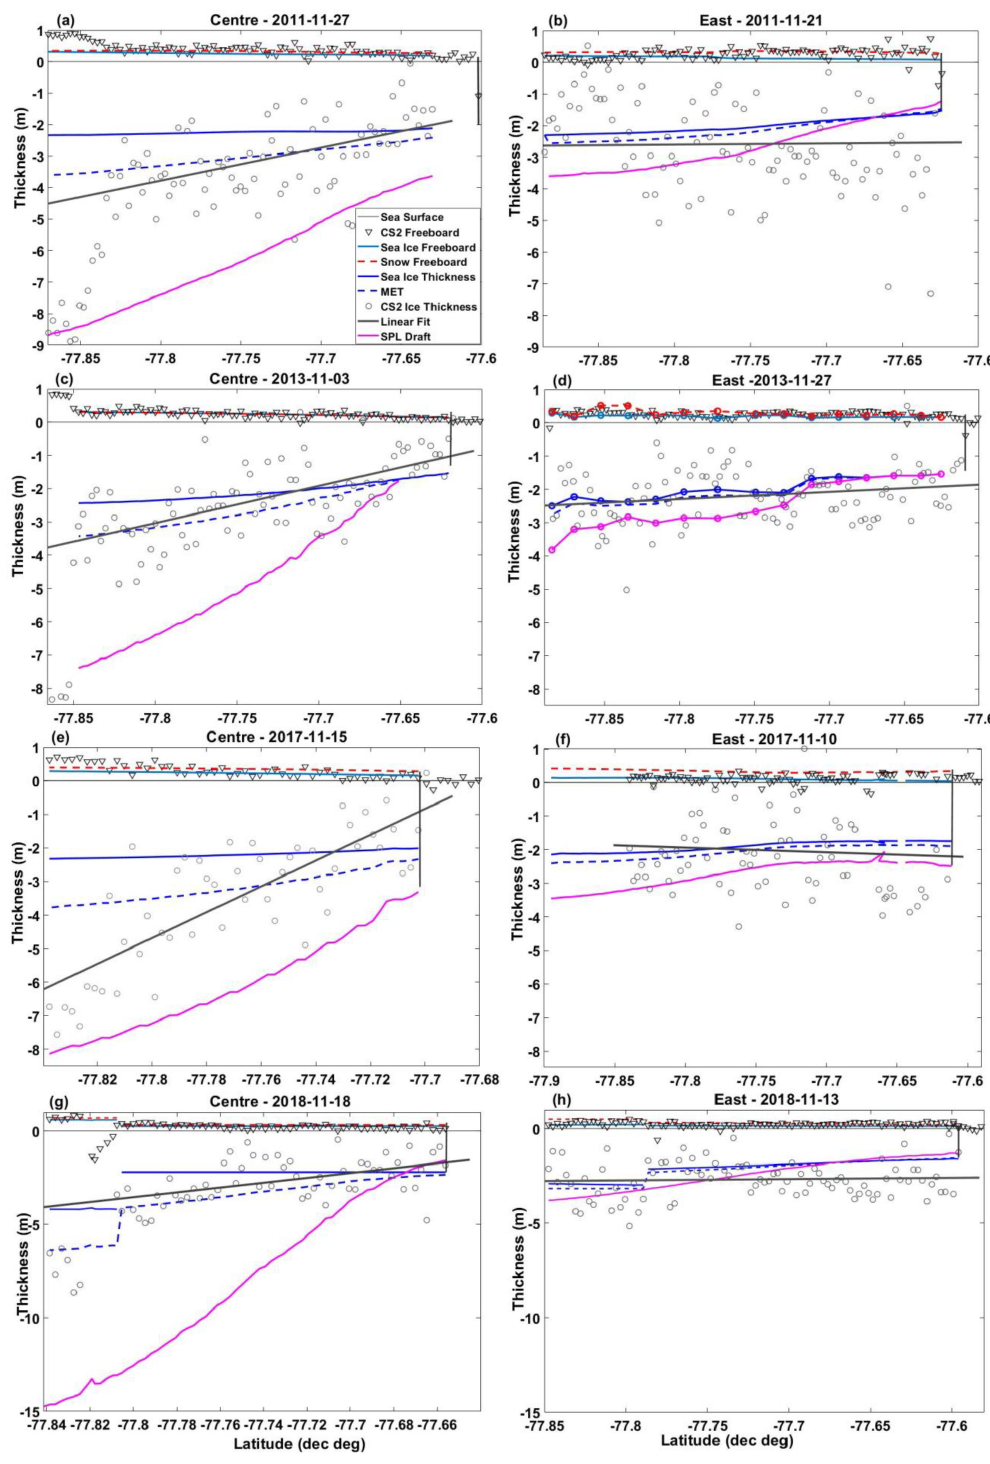
Figure 4. Comparison of along-track profiles of CS2 freeboard and CS2 ice thickness in the centre ( a , c , e and g ) and east ( b , d , f and h ) for 2011, 2013, 2017 and 2018. The McMurdo Ice Shelf is located in the south (left) of all profiles. Linear fits applied to CS2 ice thickness (over first-year ice only) are shown with interpolated drill hole sea ice and SPL thicknesses, MET, and sea ice and snow freeboard. A drill hole validation line was carried on along the eastern CS2 track on the 27 November 2013 by Price et al. (2015), and drill-hole-measured snow and sea ice freeboard, sea ice and SPL thickness, and MET are included in panel (d) (circles).